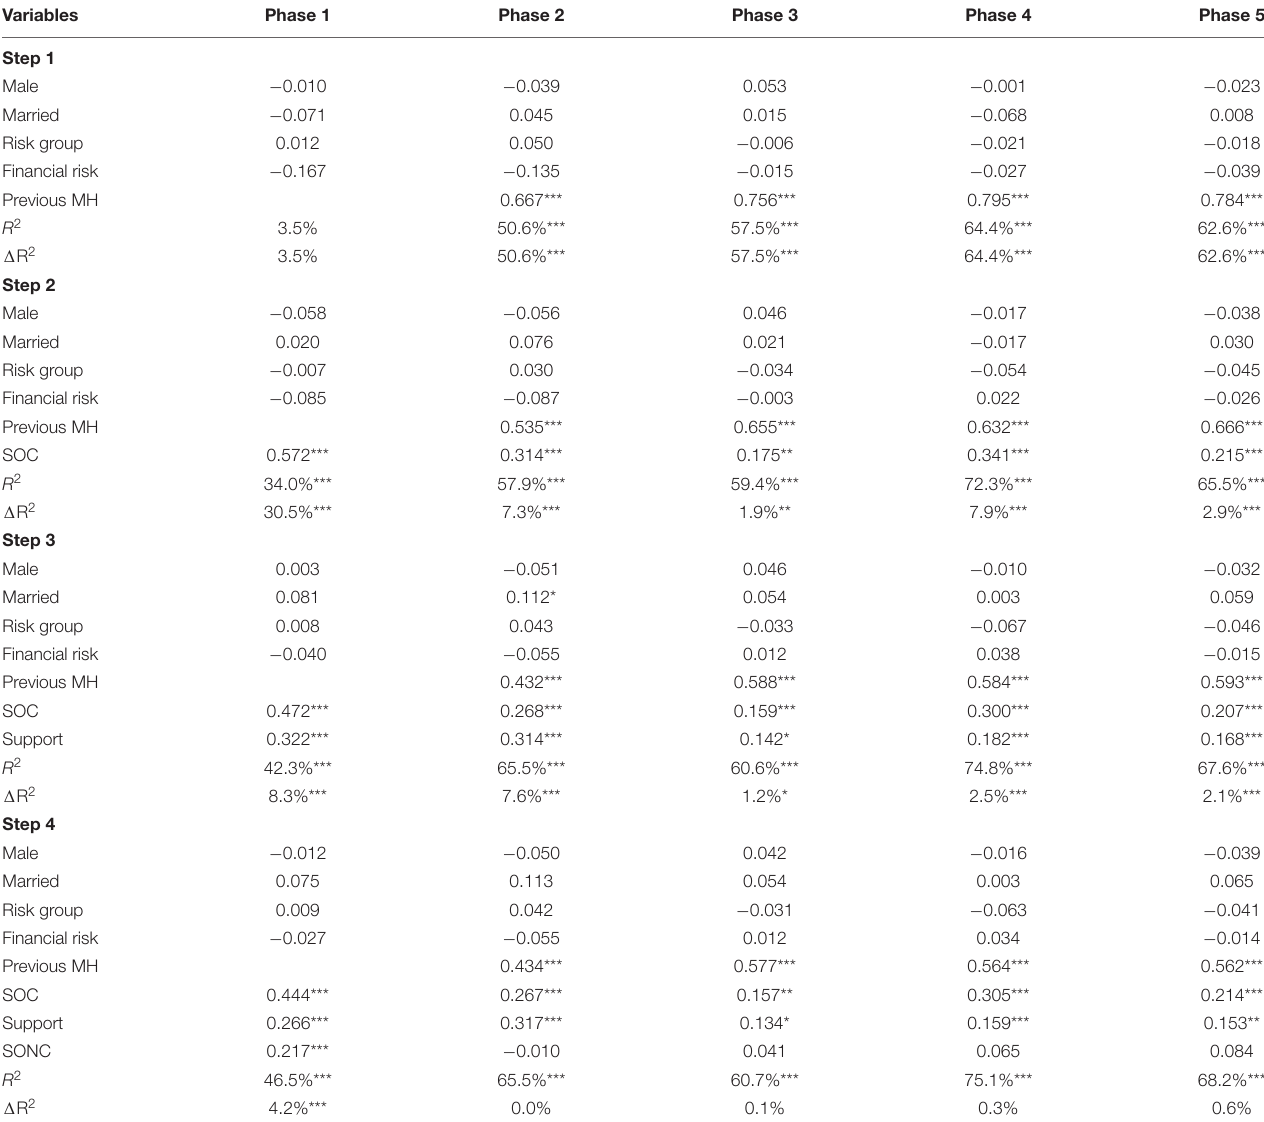
TABLE 3 | Beta values for predicting mental health by coping resources and situational and demographic variables, separately for each